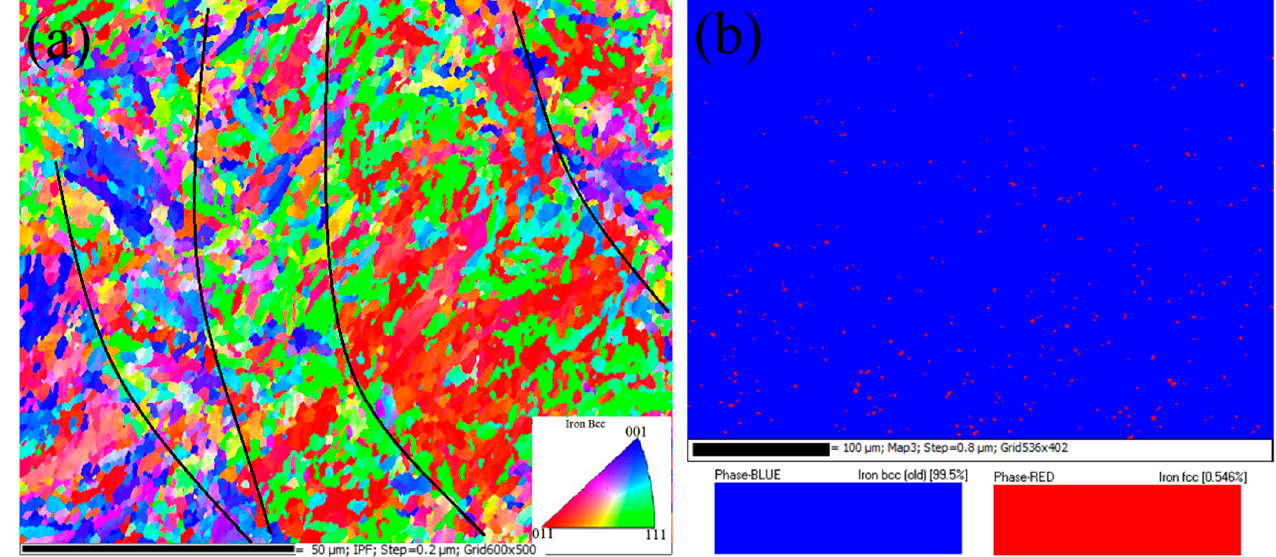
Figure 5. Microstructure of the SLM sample. (( a ) OM, ( b ) SEM).